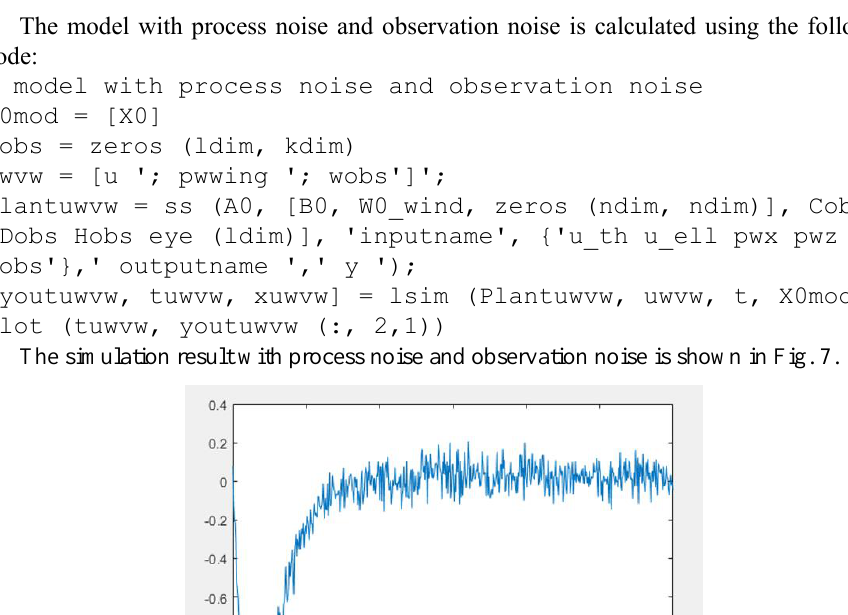
Fig. 6 . The result of modeling a stabilization system with process noise.